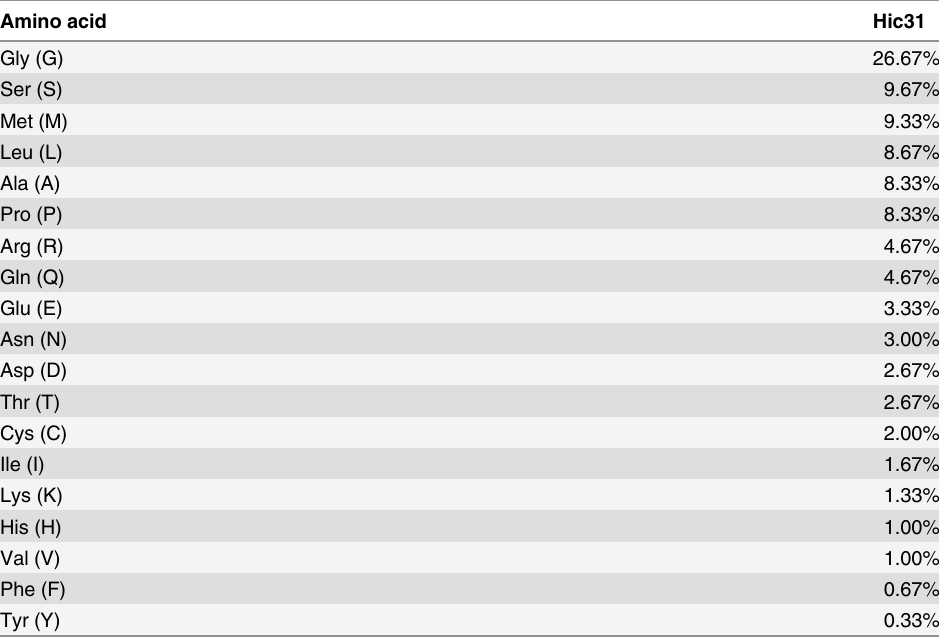
Table 1. Amino acid composition (mole percent) of